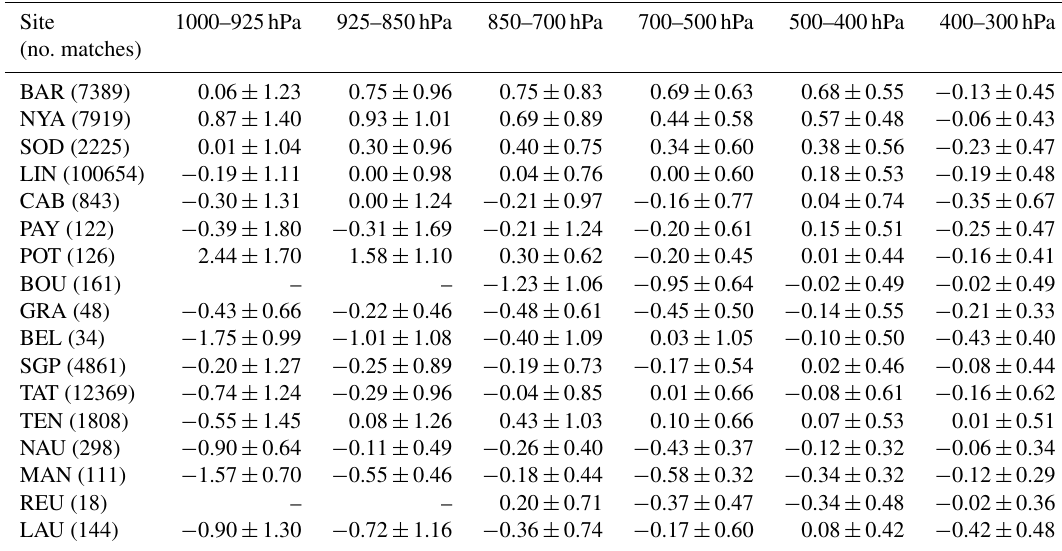
Table 2. As Table 1, breakdown of GRUAN site-specific IMS temperature profile biases and standard errors (given in K) for the same layers shown in Fig. 7.